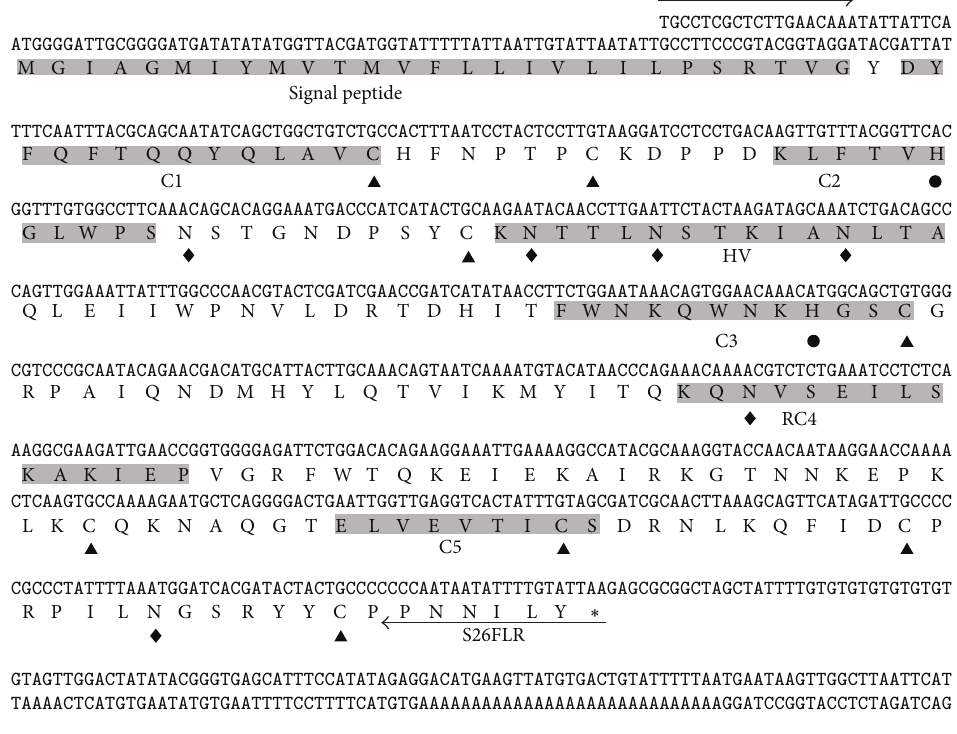
-RNase and the PcSa-RNase. Amino acid differences are indicated by asterisk. 26